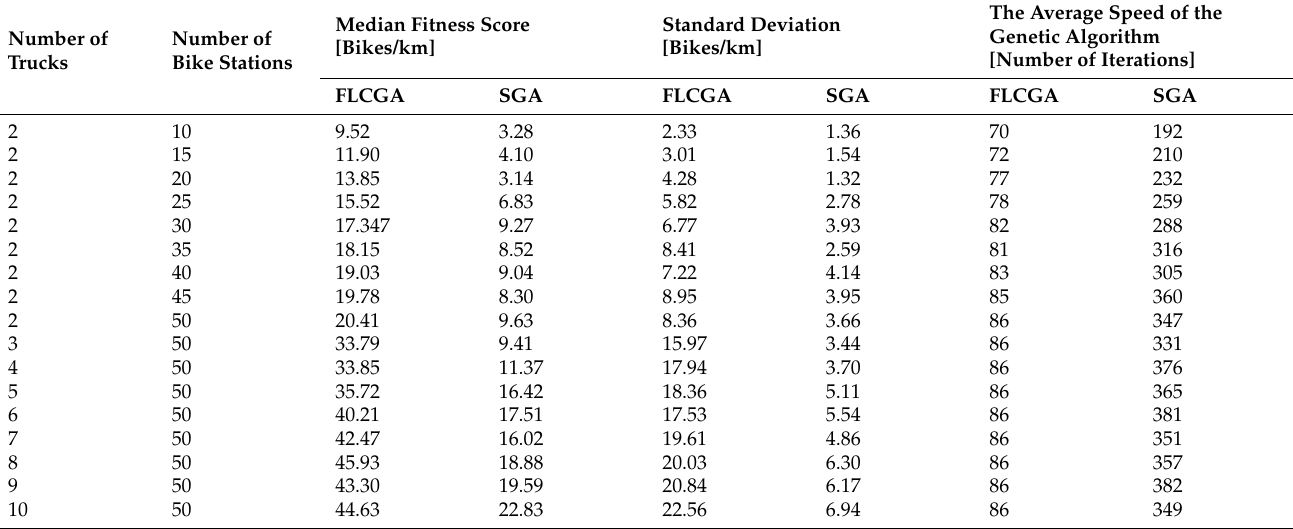
Table 9. Performance comparison of FLCGA and